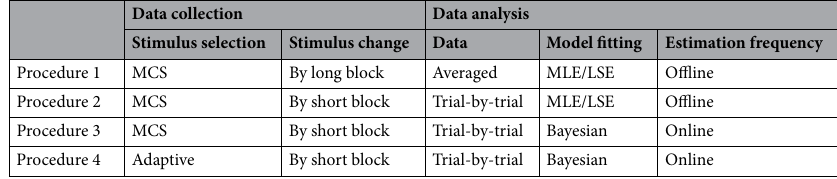
Table 2. Procedures for estimating SAT functions and their parameters. MCS: method of constant stimuli, MLE: maximum likelihood estimation, LSE: least square